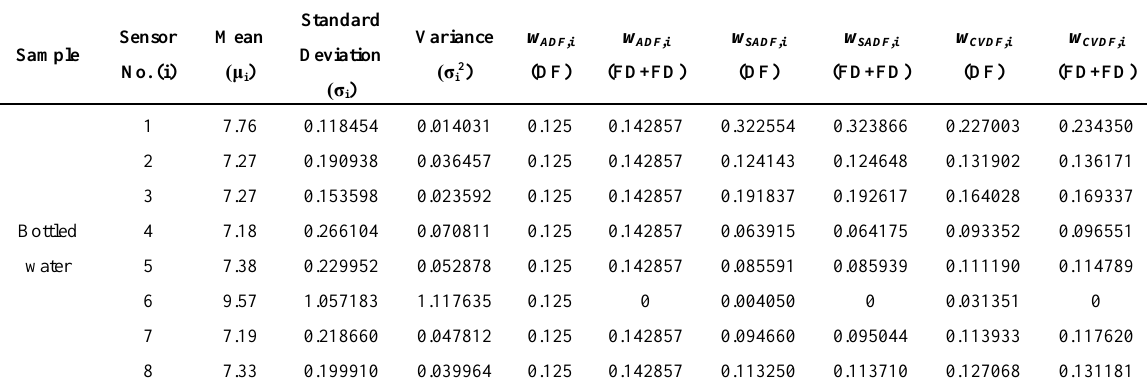
Table 3. Comparison of weighted coefficients of ADF, SADF and CVDF with fault diagnosis and obtained from the mean, standard deviation and variance of sensor measured data (sample: bottled water).